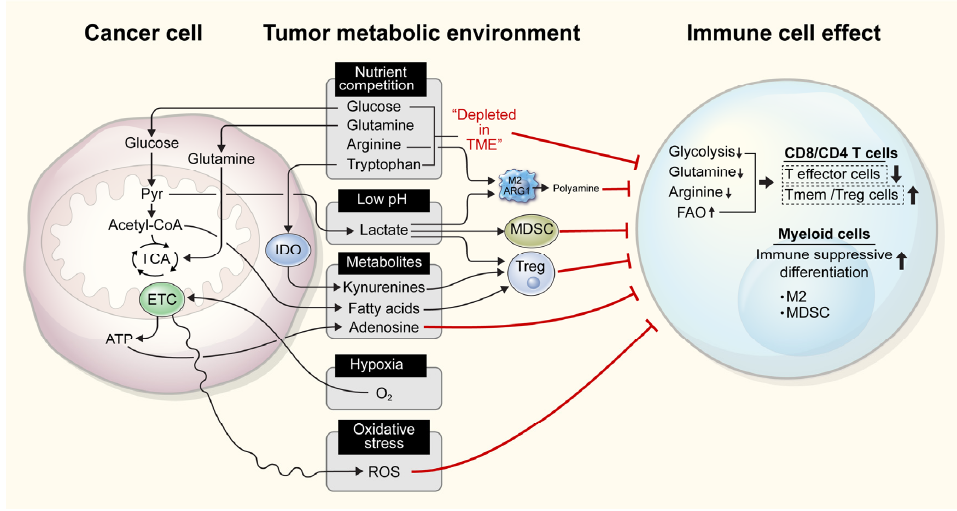
Figure 1. Competition for nutrients between immune and tumor cells in the tumor microenvironment (TIME) can affect immune cell function. In the TIME, tumor cells with high metabolic activity compete for nutrients, comprising of glucose, glutamine, arginine, and tryptophan, which are also required for immune cell function. Subsequently, the limited availability of these nutrients affects the proper function and clonal proliferation of immune cells. Further, increased glycolysis results in the production of lactate, which lowers the pH in the TIME and suppresses effector immune cell functions, while increasing the function of immunosuppressive cells, such as myeloid-derived suppressor cells (MDSCs), regulatory T cells (Tregs), and M2 macrophages. Tumor cells also release fatty acids, adenosine, and kynurenine, which activate immune tolerogenic cells and simultaneously repress immune cell effector functions. Heightened oxygen consumption and the resulting hypoxia, as well as the release of reactive oxygen species (ROS), in the TIME also inhibit anticancer immunity. M2, M2 macrophages; IDO, indoleamine 2,3-dioxygenase; ETC, electron transport chain; ARG1, arginase 1; FAO, fatty acid oxidation; TCA, tricarboxylic acid; ROS, reactive oxygen